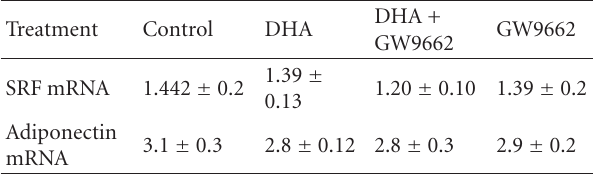
Table 1: SRF and adiponectin expression in mouse adipocytes.